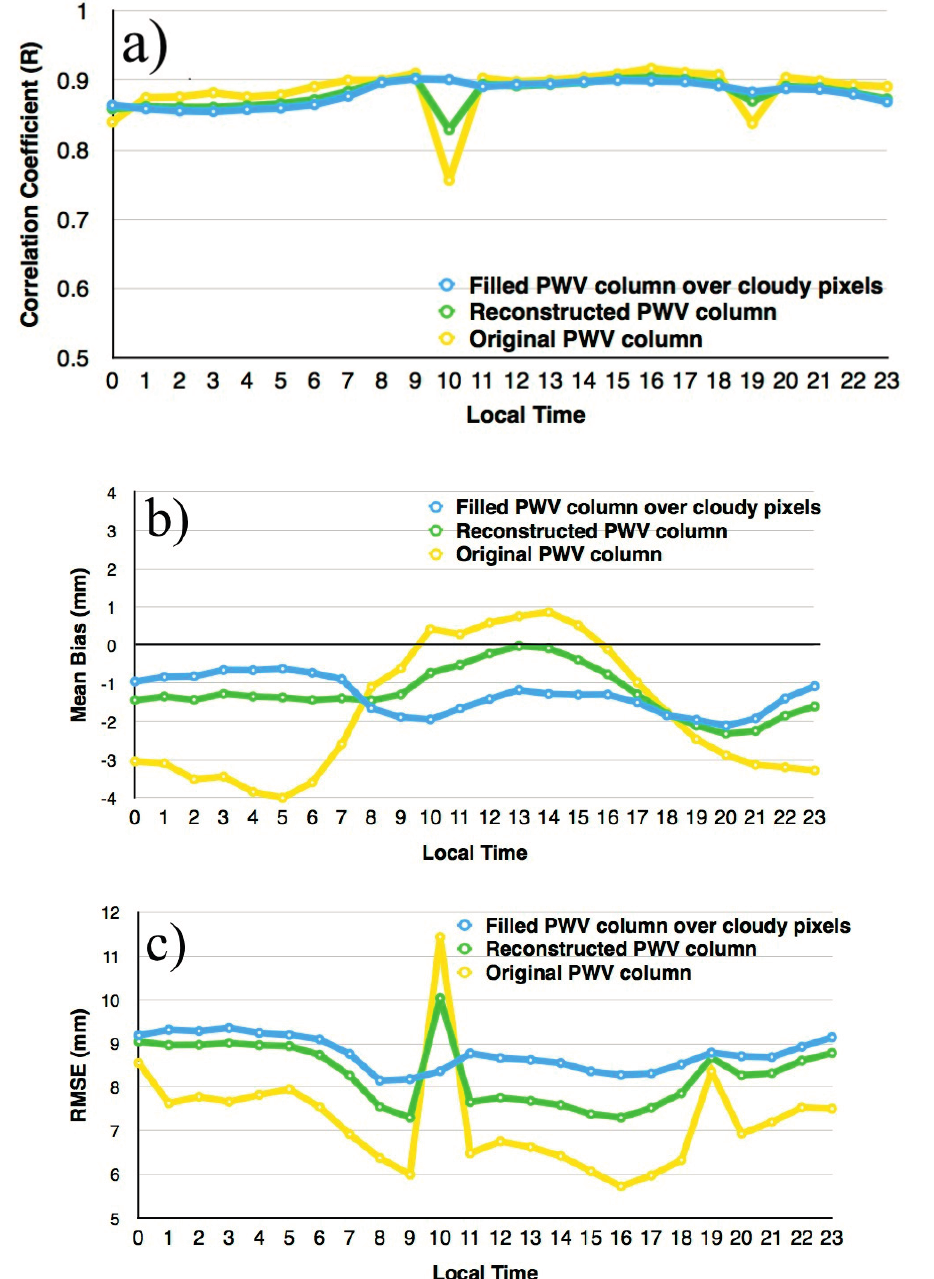
Figure 7. GPS validation results at different hours of the day: ( a ) correlation coefficient; ( b ) mean bias; and ( c )